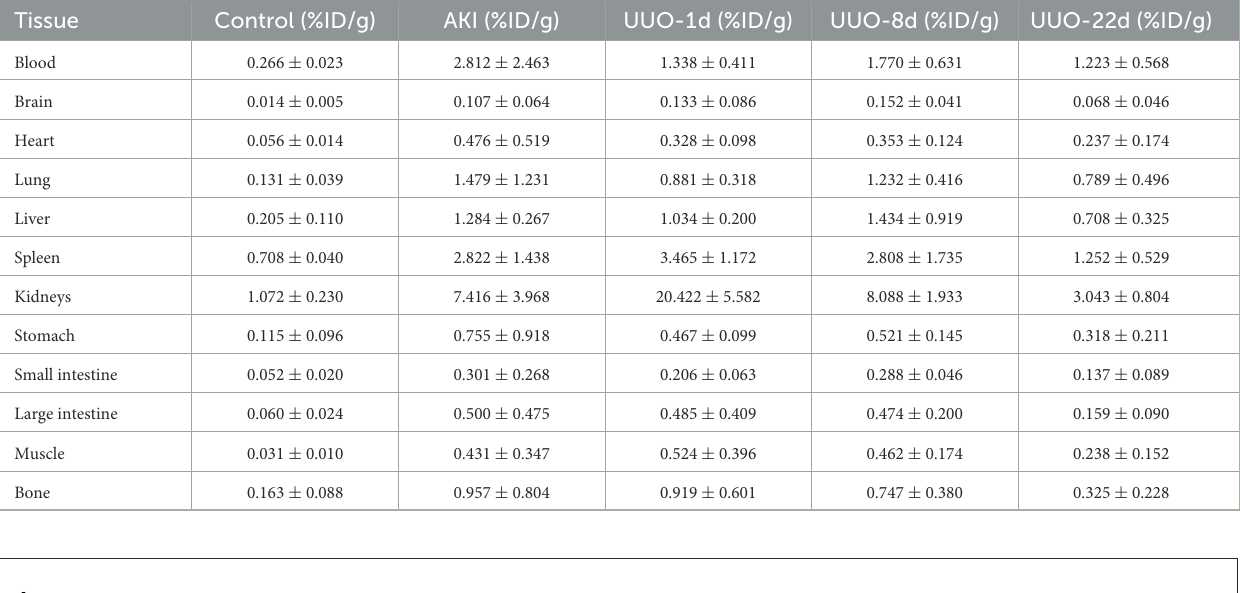
TABLE 3 Biodistribution of 68 Ga-EDTA in five groups.